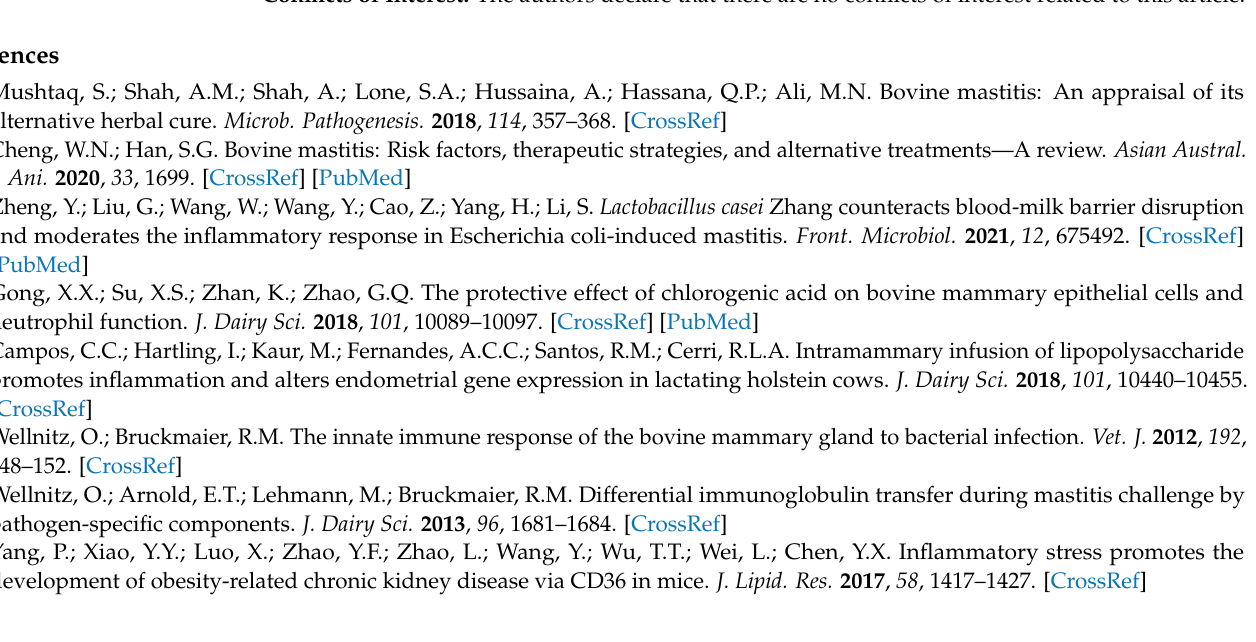
Figure 5; Figure S2: Whole Western blotting images for Figure 7; Figure S3: Whole Western blotting images for Figure